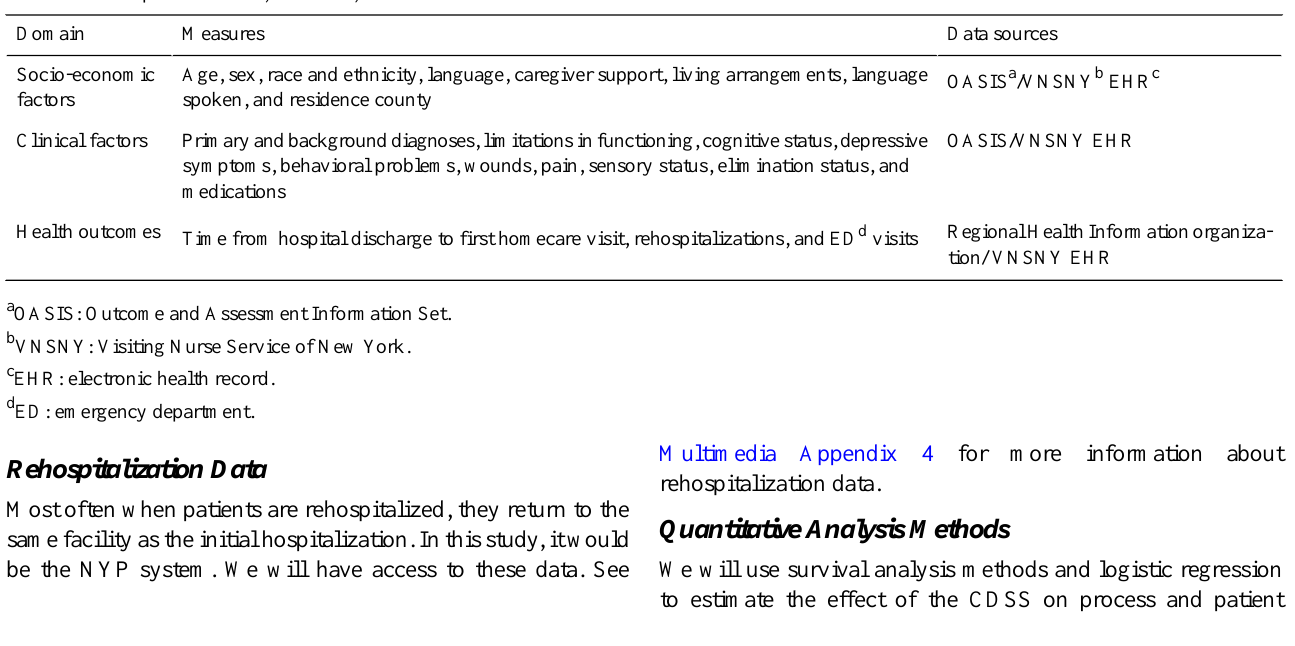
Table 2. Conceptual domains, measures, and data